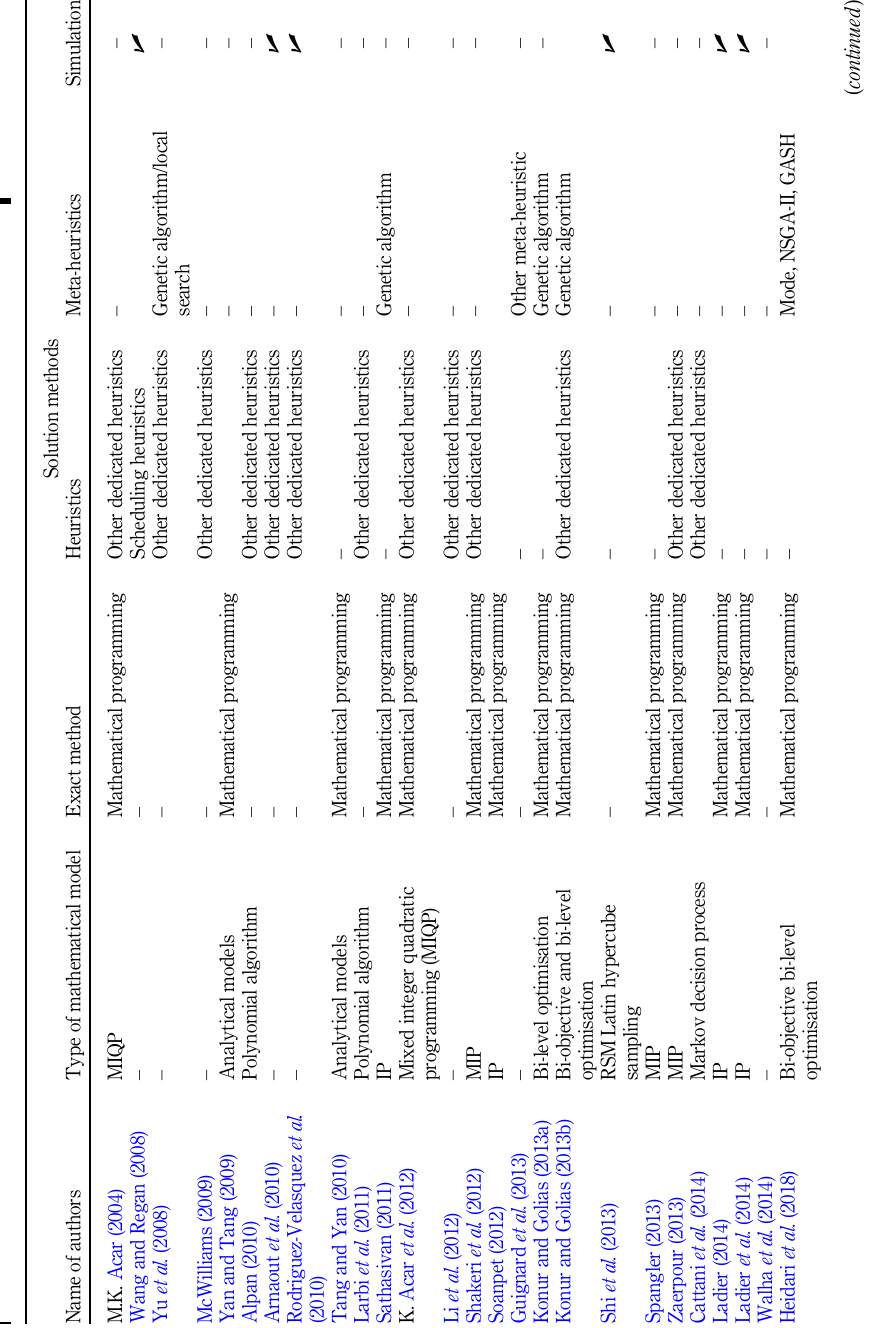
Table IV. Solution